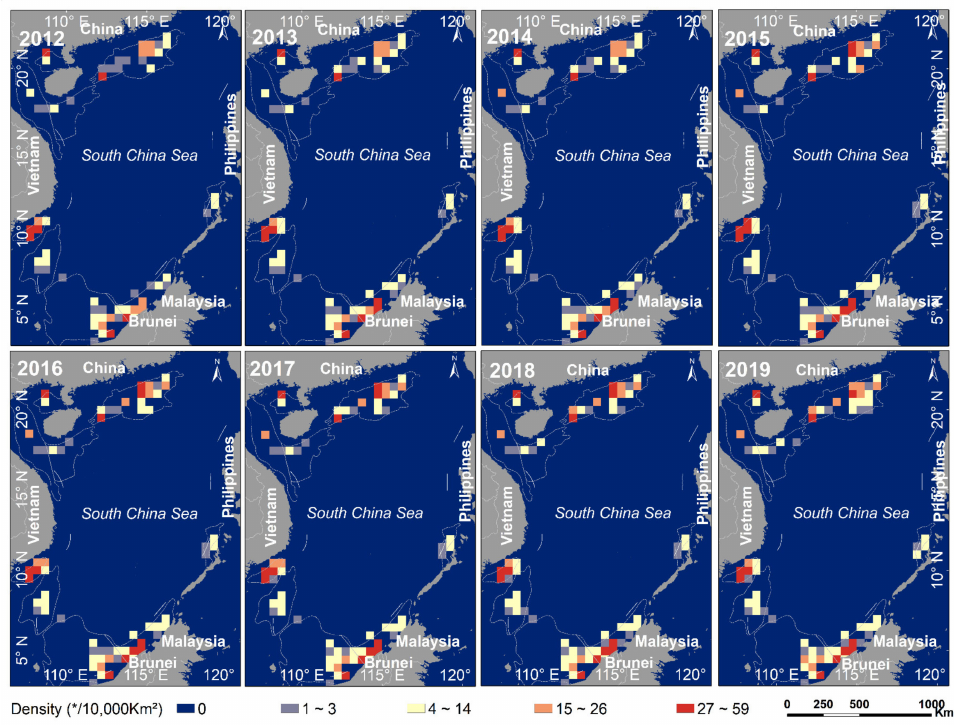
Figure 12. The spatial pattern of distribution density of offshore HE targets in each basin from 2012 to